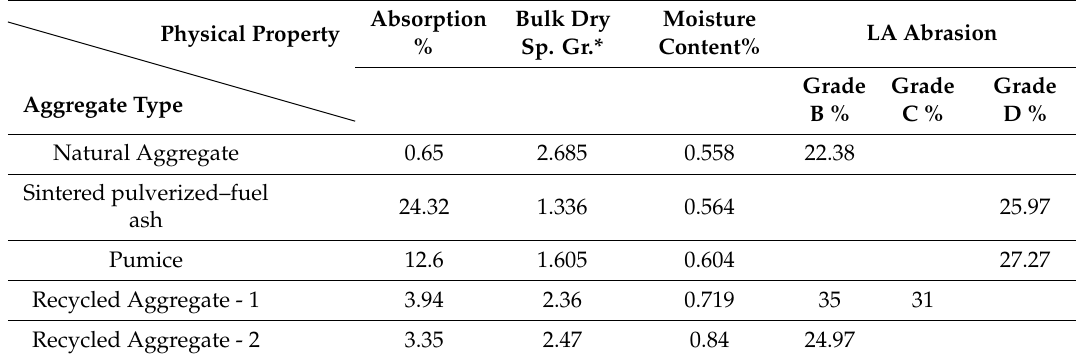
Table 4. Summary of the coarse aggregate properties.